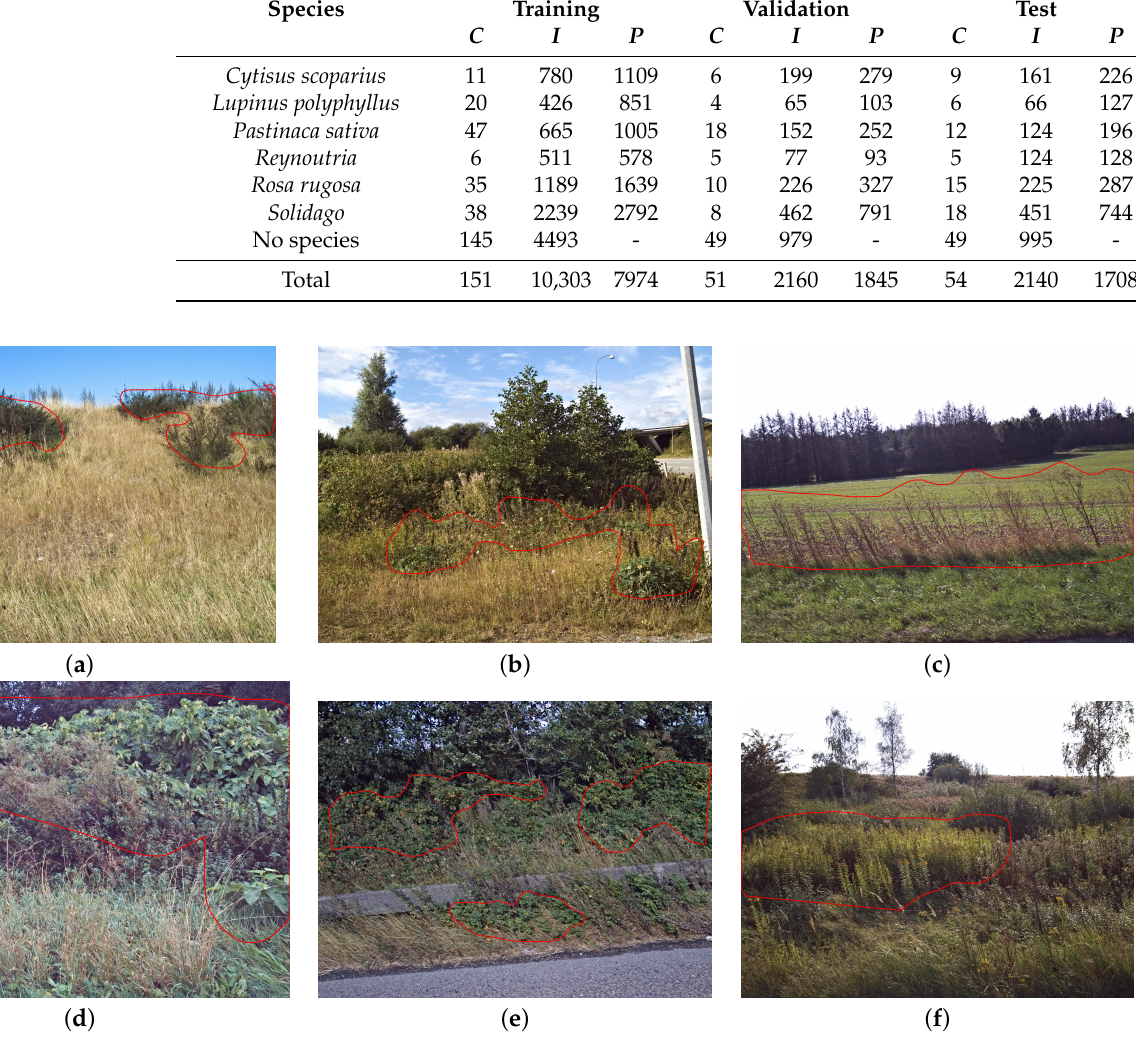
Table 2. Overview of training, validation, and test set. C , I , and P are the number of clusters, images, and polygons of each species in the respective data sets. A cluster consists of multiple images